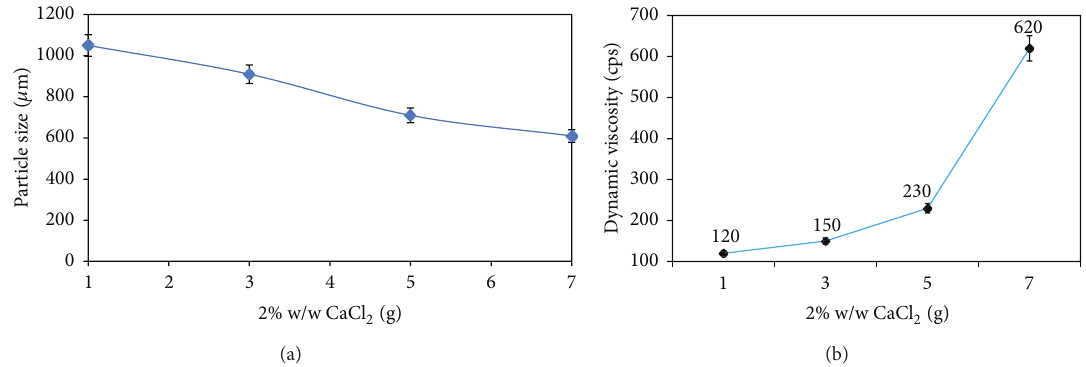
Figure 7: Effect of CaCl 2 on (a) particle size and (b) dynamic viscosity of 10:5 SA/CMC blend crosslinked with Ca 2+ .